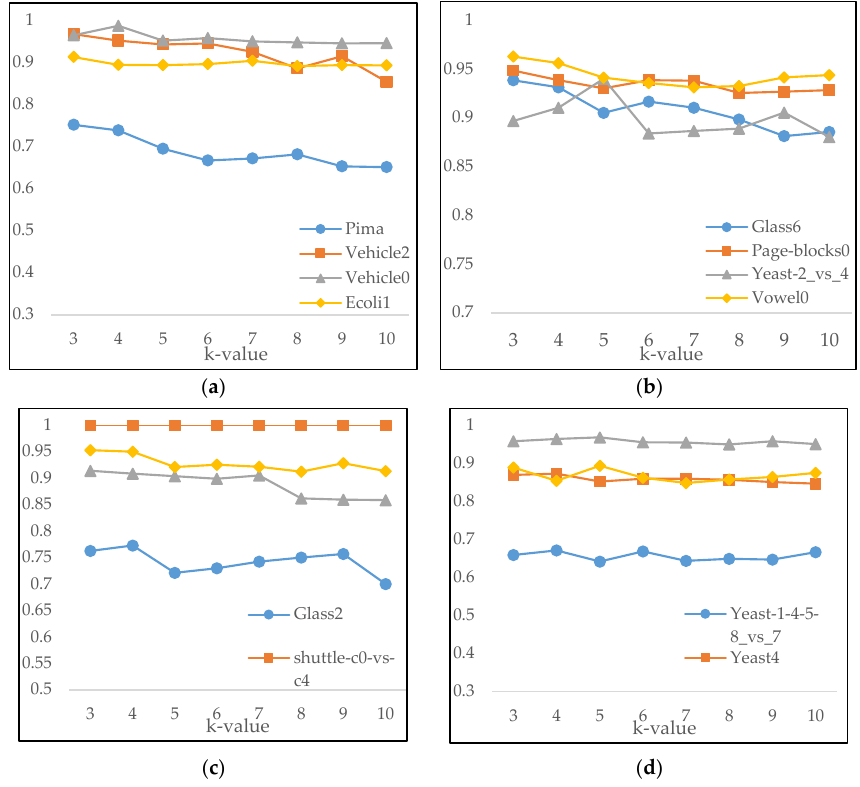
Figure 9. ( a ) AUC comparison of di ff erent k -values on D1–D4; ( b ) AUC comparison of di ff erent k -values on D5–D8; ( c ) AUC comparison of di ff erent k -values on D9–D12; ( d ) AUC comparison of di ff erent k -values on